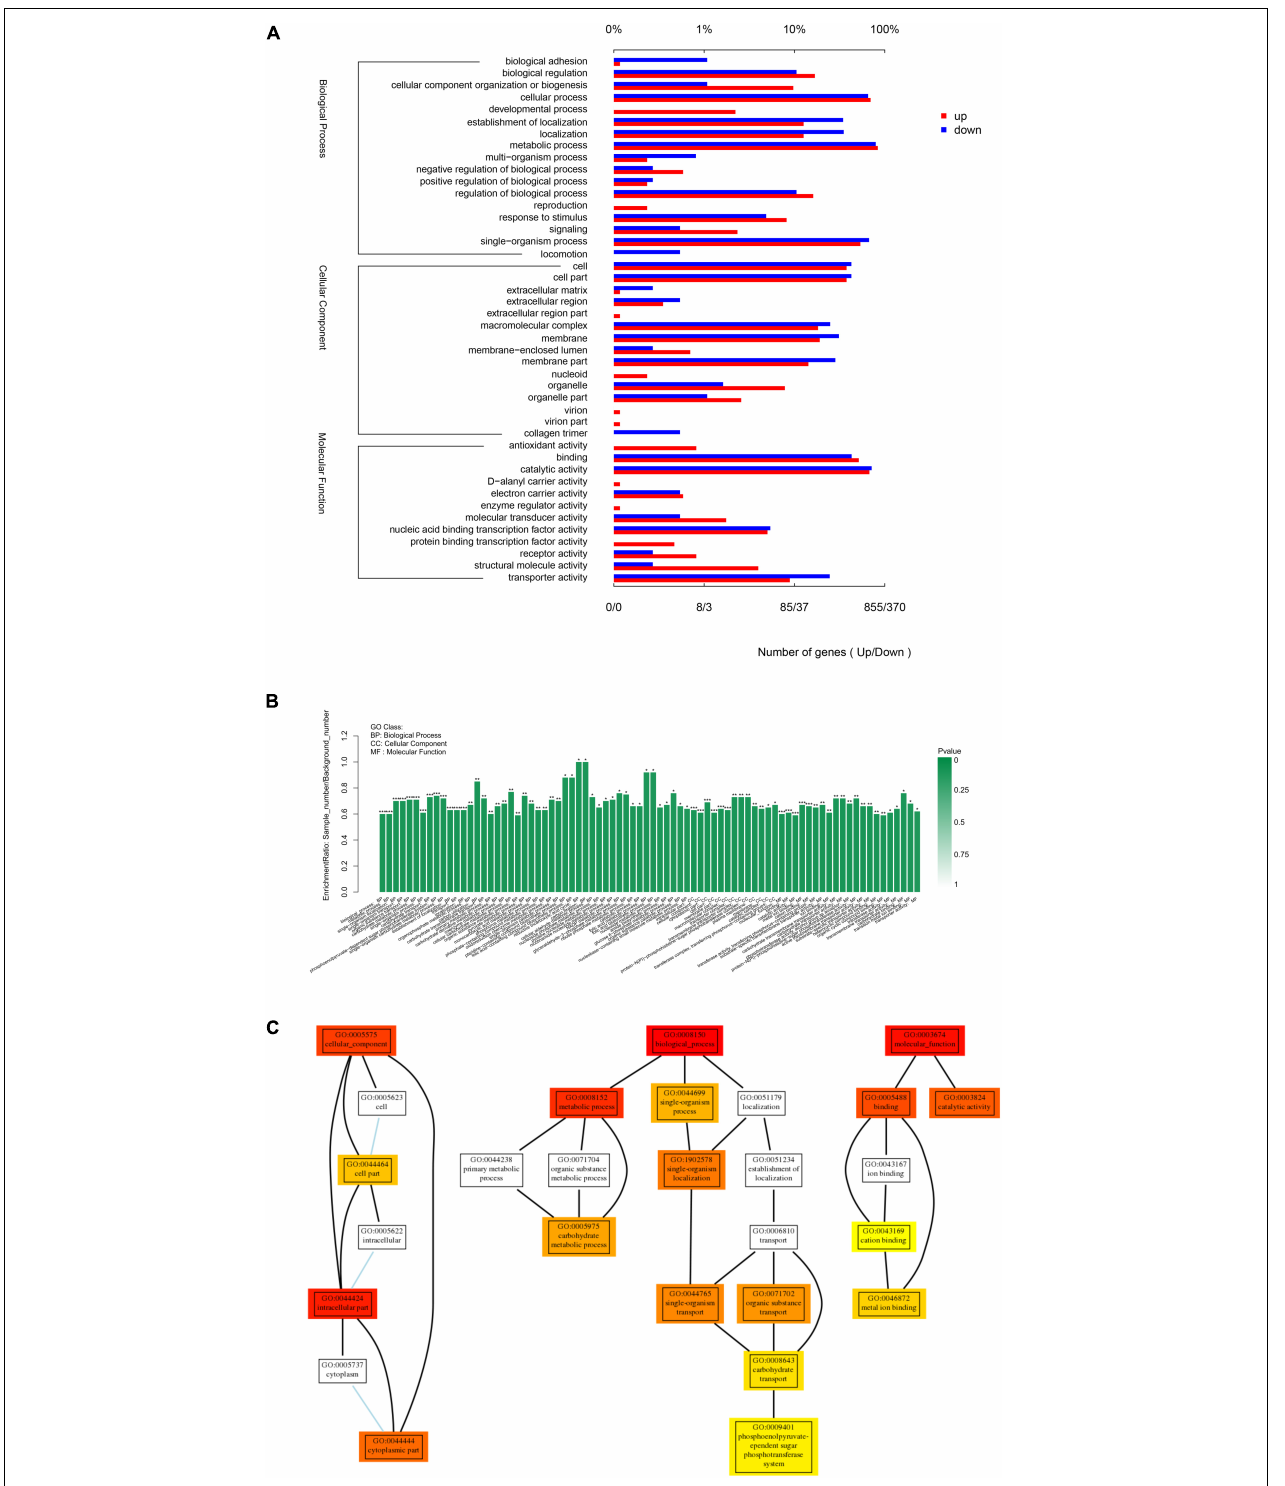
FIGURE 7 | Gene Ontology (GO) analysis of differentially expressed genes. (A) GO classification of DEGs. (B) GO enrichment of DEGs. Genes were annotated in three main categories: biological process, cellular component and molecular function. (C) Go hierarchical structure. The three sub-graphs represented the three categories of GO as mentioned above, each rectangle represented a GO term. The colored rectangle represented the GO term with significant difference, the closer the color was to red, the more significant the difference. The line between GO terms represented the relationship between two GOs. “ ∗ ” Indicated significantly enrichment. P < 0.001 were labeled as “ ∗∗∗ ”, P < 0.01 were labeled as “ ∗∗ ”, and P < 0.05 were labeled as “ ∗ ”.